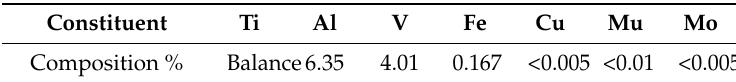
Table 2. Mechanical properties for Ti6Al4V. Table 1. Chemical composition of the Ti6Al4V.